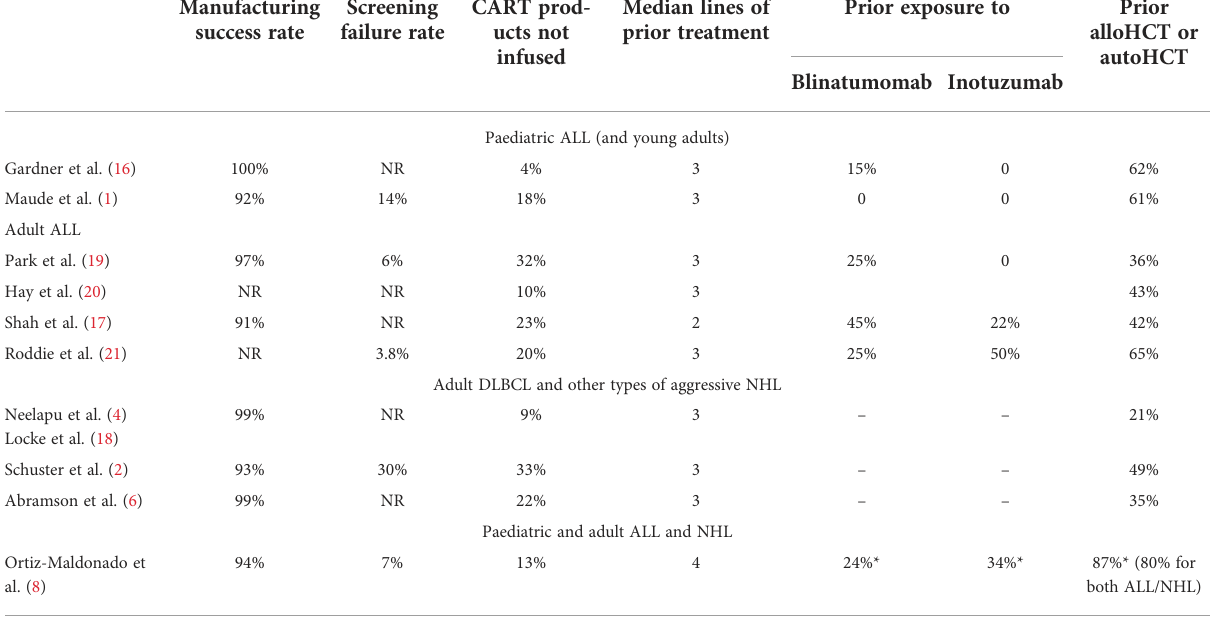
TABLE 1 Manufacturing results and patients ’ baseline characteristics for different CART-cell products targeting CD19 used for the treatment of relapsed/refractory B-cell